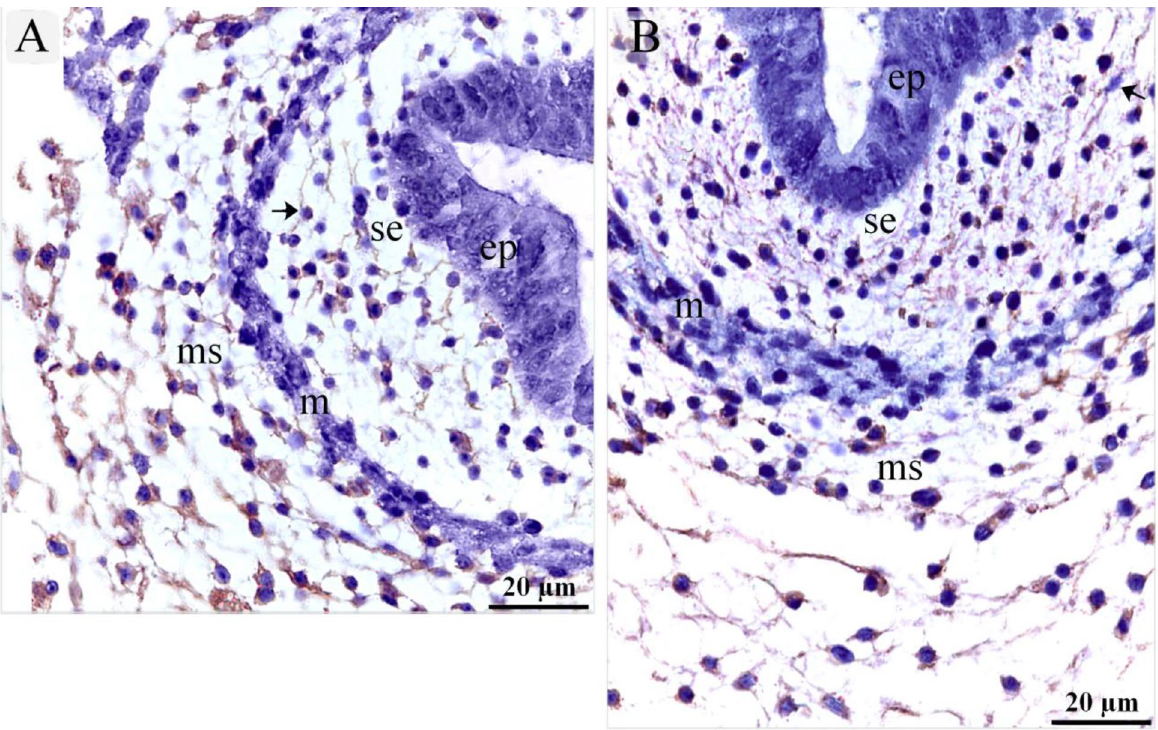
Figure 11. Immunohistochemical staining of the esophagus at day 5 using CD34 and VEGF. Immunostained paraffin sections of day 5 for CD34 ( A ) and VEGF ( B ). ( A ) CD34 positive cells were identified in subepithelial tissue (se) and mesenchyme (ms). Strong CD34 positive TCs (arrows) were distinguished by cell prolongations (telopodes). Note the epithelium (ep), myoblasts (m). ( B ) VEGF positive cells were identified in the subepithelial tissue (se), and mesenchyme (ms). VEGF positive TCs (arrows) were distinguished by cell prolongations (telopodes). ( C ) CD34 positive cells were identified in the epithelium (ep), lamina propria (LP). Note the epithelium (ep), myoblasts